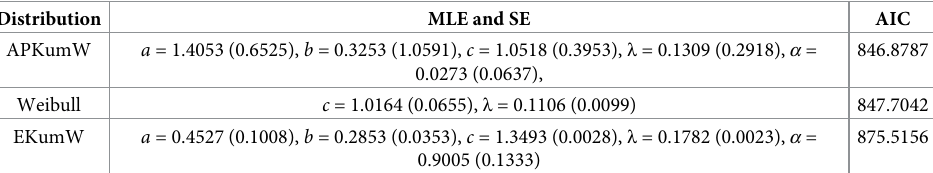
Table 8. MLE, (SE) for the parameters and associated goodness of fit statistics for the censored data.